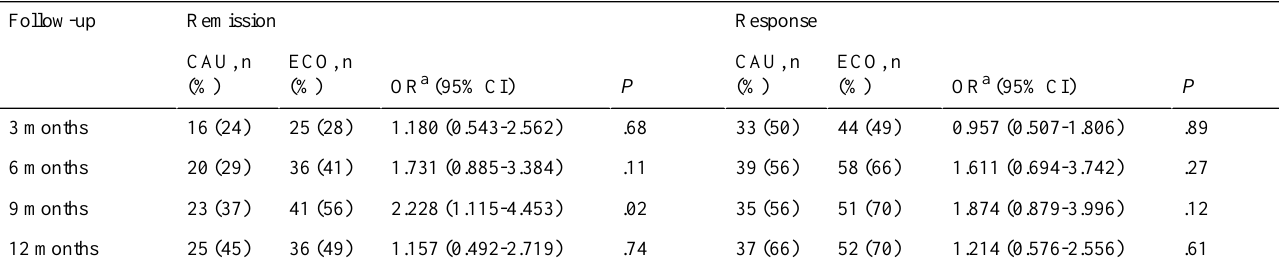
Table 3. Results on remission and response for both groups. ResponseRemissionFollow-up